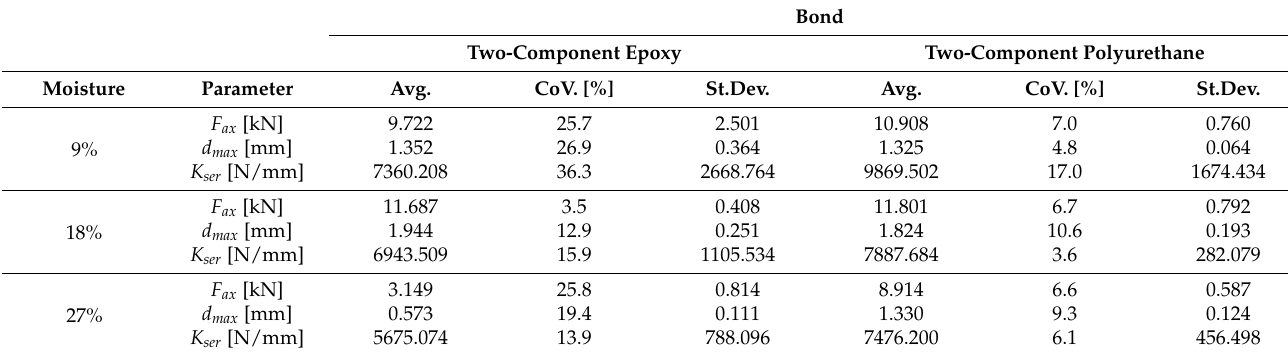
Table 4. Maximum axial force, displacement and slip modulus for specimens with perpendicular rod-to-grain arrangement (mean experimental